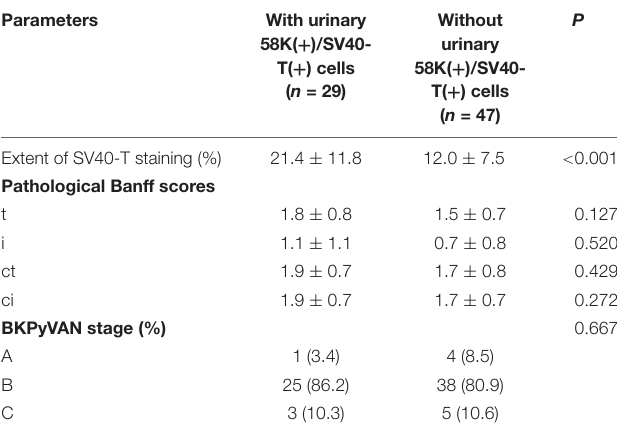
TABLE 2 | Pathological characteristics between patients with urinary 58K( + )/SV40-T( + ) cells and those without urinary 58K( + )/SV40-T( + ) cells. Parameters